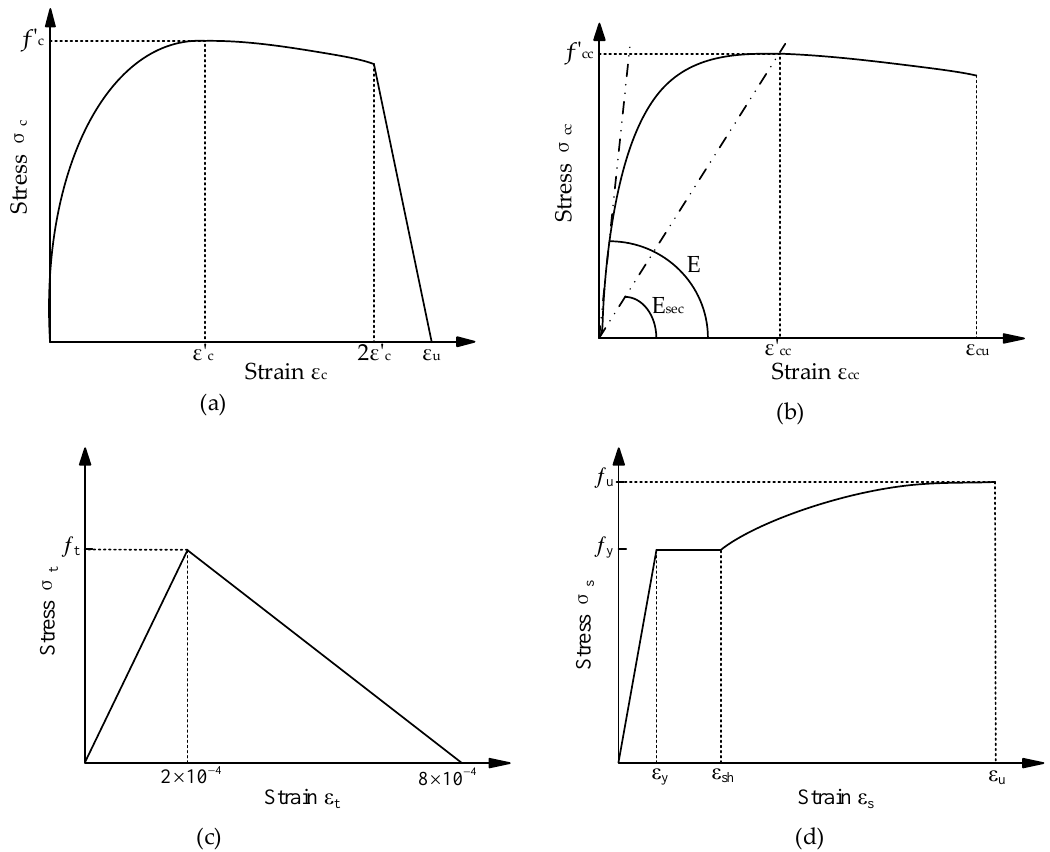
Figure 3. Stress − strain relationship of materials: ( a ) Mander − unconfined concrete; ( b ) Mander − con- Figure 3. Stress-strain relationship of materials: ( a ) Mander-unconfined concrete; ( b ) Mander- fined concrete; ( c ) tensile concrete; ( d ) steel reinforcements. confined concrete; ( c ) tensile concrete; ( d ) steel